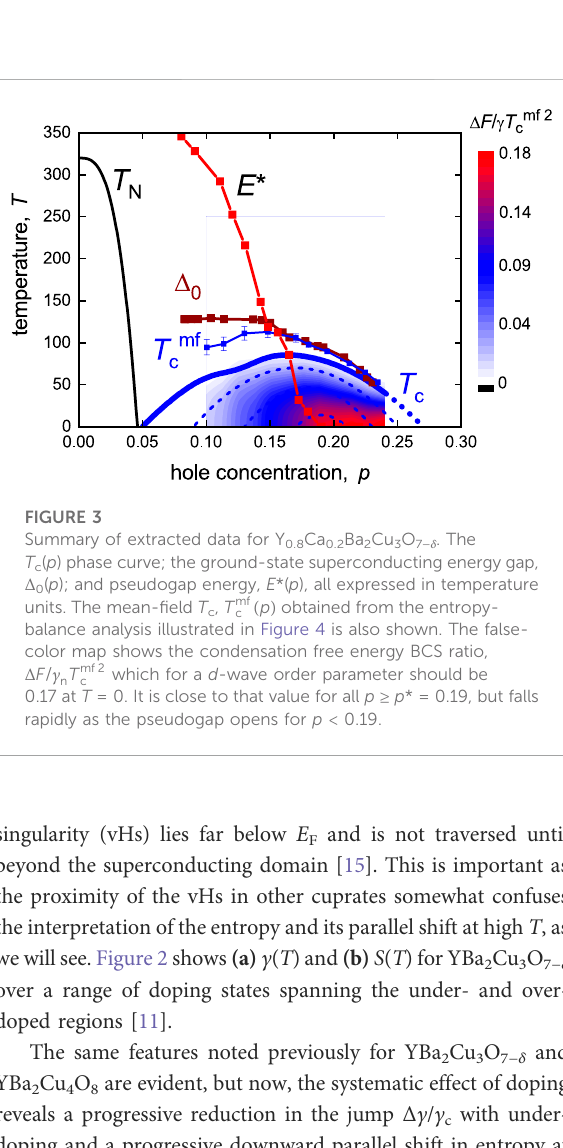
FIGURE 4 (A) Fluctuation analysis of the speci fi c heat coef fi cient, γ ( T ), for Y 0.8 Ca 0.2 Ba 2 Cu 3 O 6.75 to determine the mean- fi eld T c value, fi cient γ mf and the symmetric T mf c , showing the deduced MF coef fl uctuation contribution (gray shading). By entropy balance, the hatched area equals the shaded area under the fl uctuation term. (B) Solid curve: the SC energy gap Δ 0 calculated using Eq. 2 and dashed curve: its MF value, Δ mf 0 calculated from γ mf in (A) . (C) Solid curve: the entropy difference Δ S = S s − S n calculated